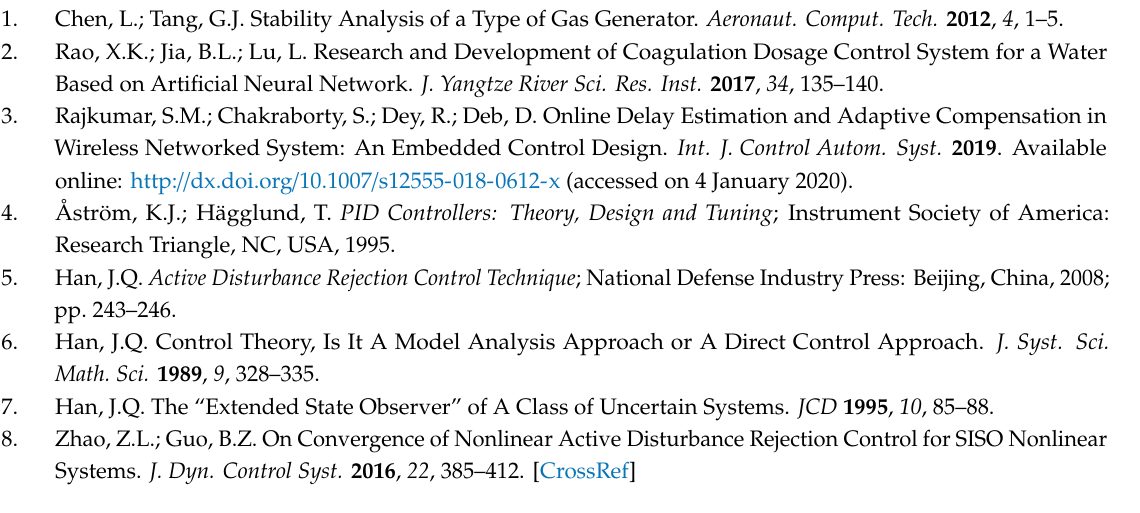
Figure 17. Step Response of Second-Order Time-Delay System for 𝜔 (cid:3030) = 0.0473 When 𝐾 = 40.626 .